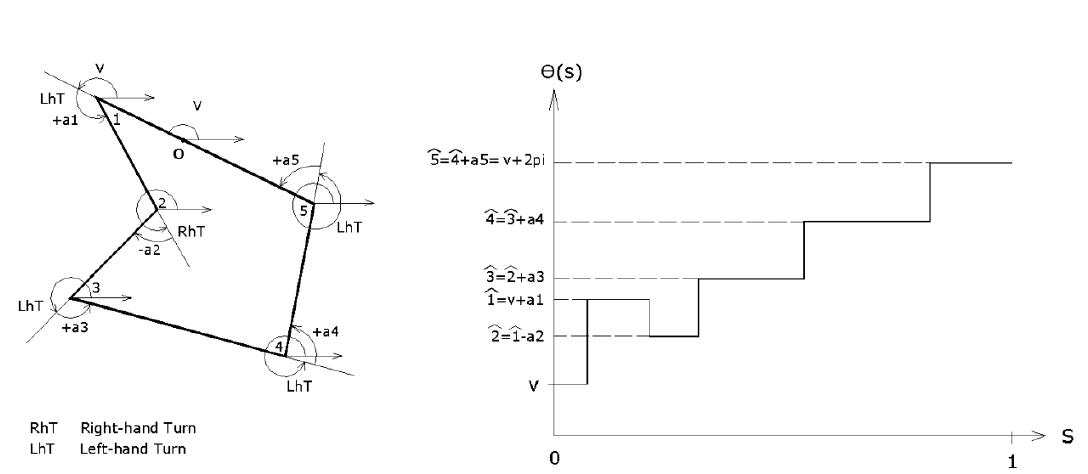
(cid:4666)(cid:1871)(cid:4667) . ( s ) (cid:3250) A